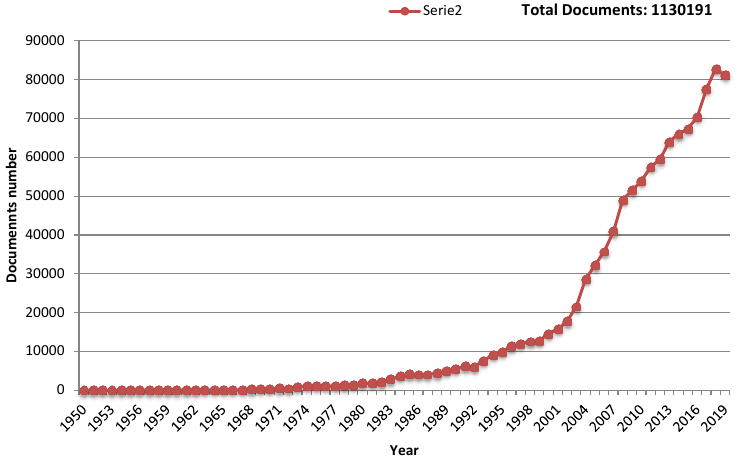
Figure 1. Number of publications per year with titles, abstract or keywords including the term “sensor” (Source: Scopus [2]).